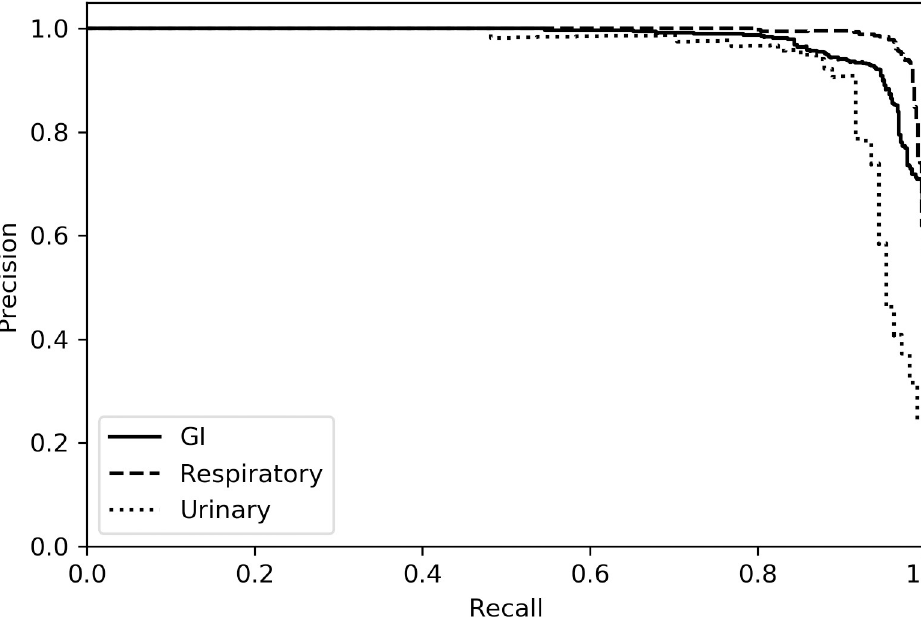
Fig 5. Precision-recall curves for random forest. Confidence values for test-set predictions were pooled across cross- validation folds. Areas under the curve (AUCs) are 0.981 (GI), 0.994 (respiratory), and 0.947 (urinary).